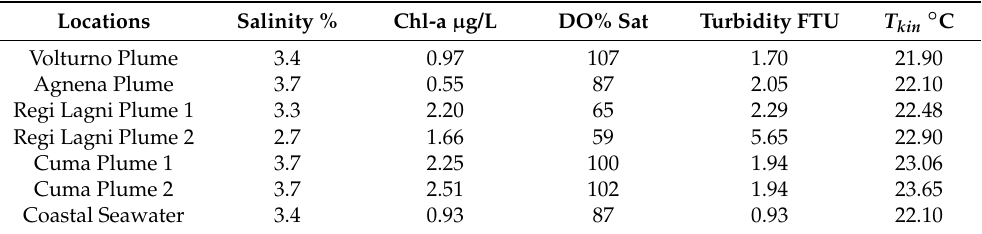
Table 2. Water quality parameters measured during the in situ field campaign, with salinity in %, chlorophyll-a in μ g/L, dissolved oxygen (DO) in % saturation, turbidity in Formazin turbidity units (FTU), and kinetic temperature in °C.